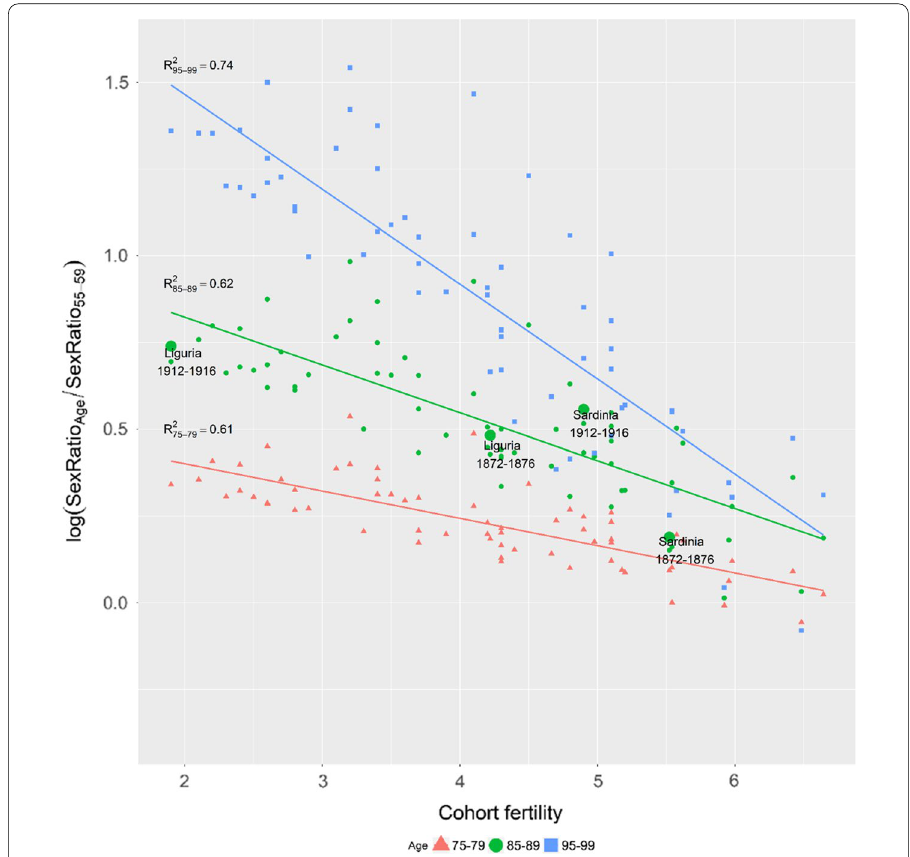
figure: ages 85–89 years of the 1872–1876 and 1912–1916 birth cohorts in Liguria, a forerunner in the fertility transition, and Sardinia, a